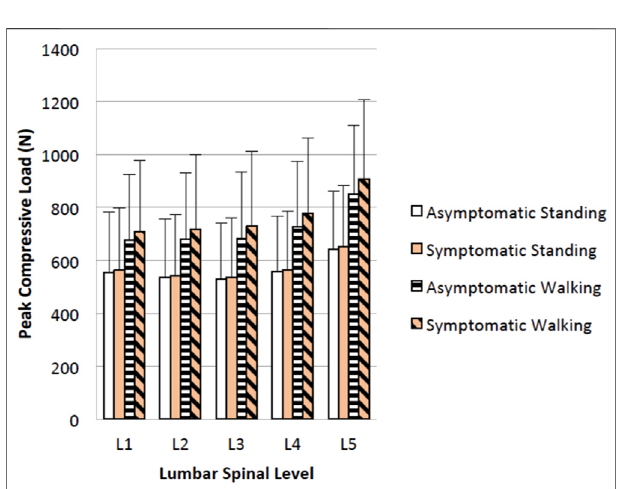
FIGURE 3 | Mean (SD) of peak lumbar loads for asymptomatic and symptomatic standing and walking.